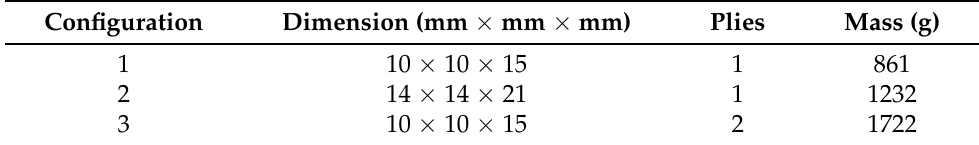
Table 12. Lattice Structure Scaling Configuration.